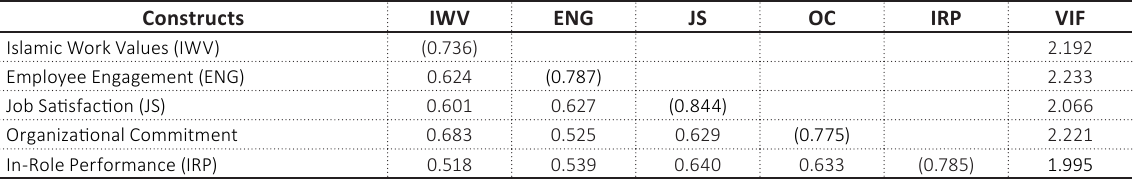
Table 3. Discriminant validity evaluation with Fornell-Larcker criterion Constructs